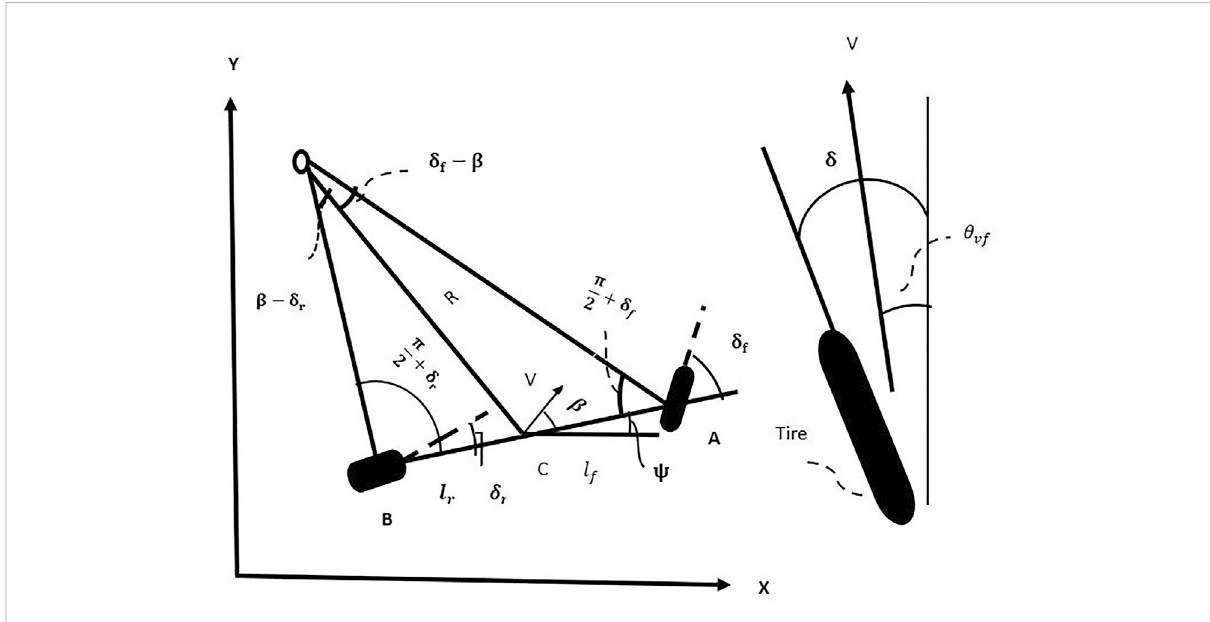
FIGURE 1 Kinematics of lateral vehicle motion.